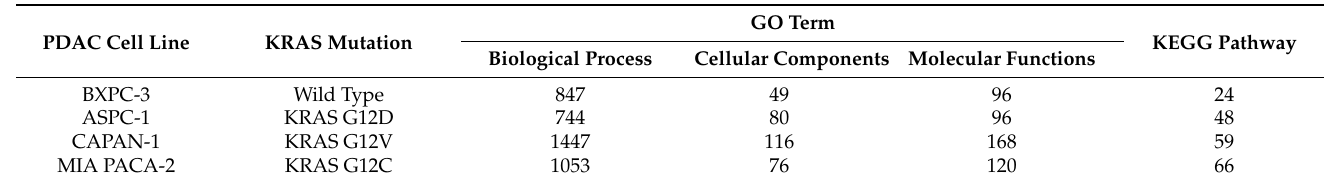
Table 3. GO term and KEGG pathway enrichment analysis of DEGs induced by BI-3406 triple inhibitor combination